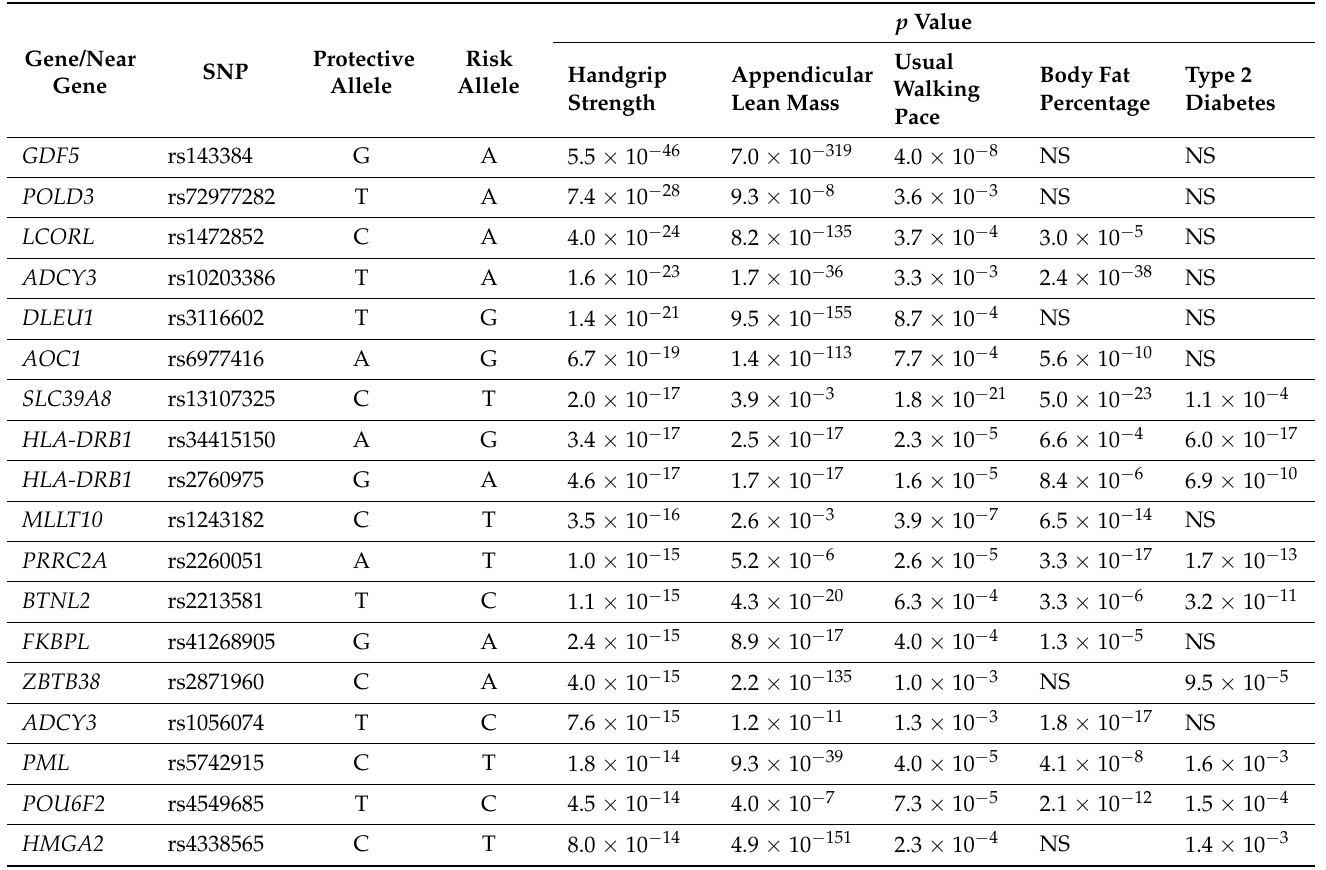
Figure 1. A schematic overview of the study design and the main findings. Table 2. DNA polymorphisms associated with sarcopenia-related traits, fat percentage and type 2